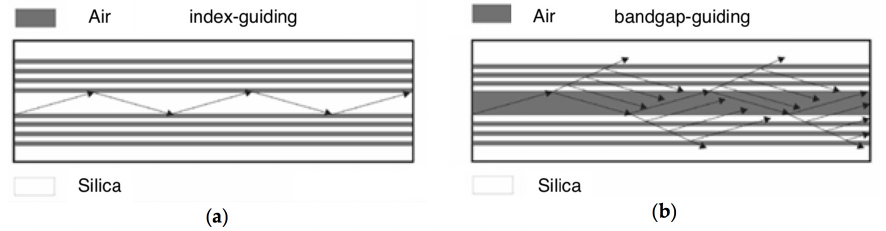
Figure 2. Guiding mechanisms in a PCF: ( a ) index-guiding. ( b ) bandgap-guiding through the photonic bandgap